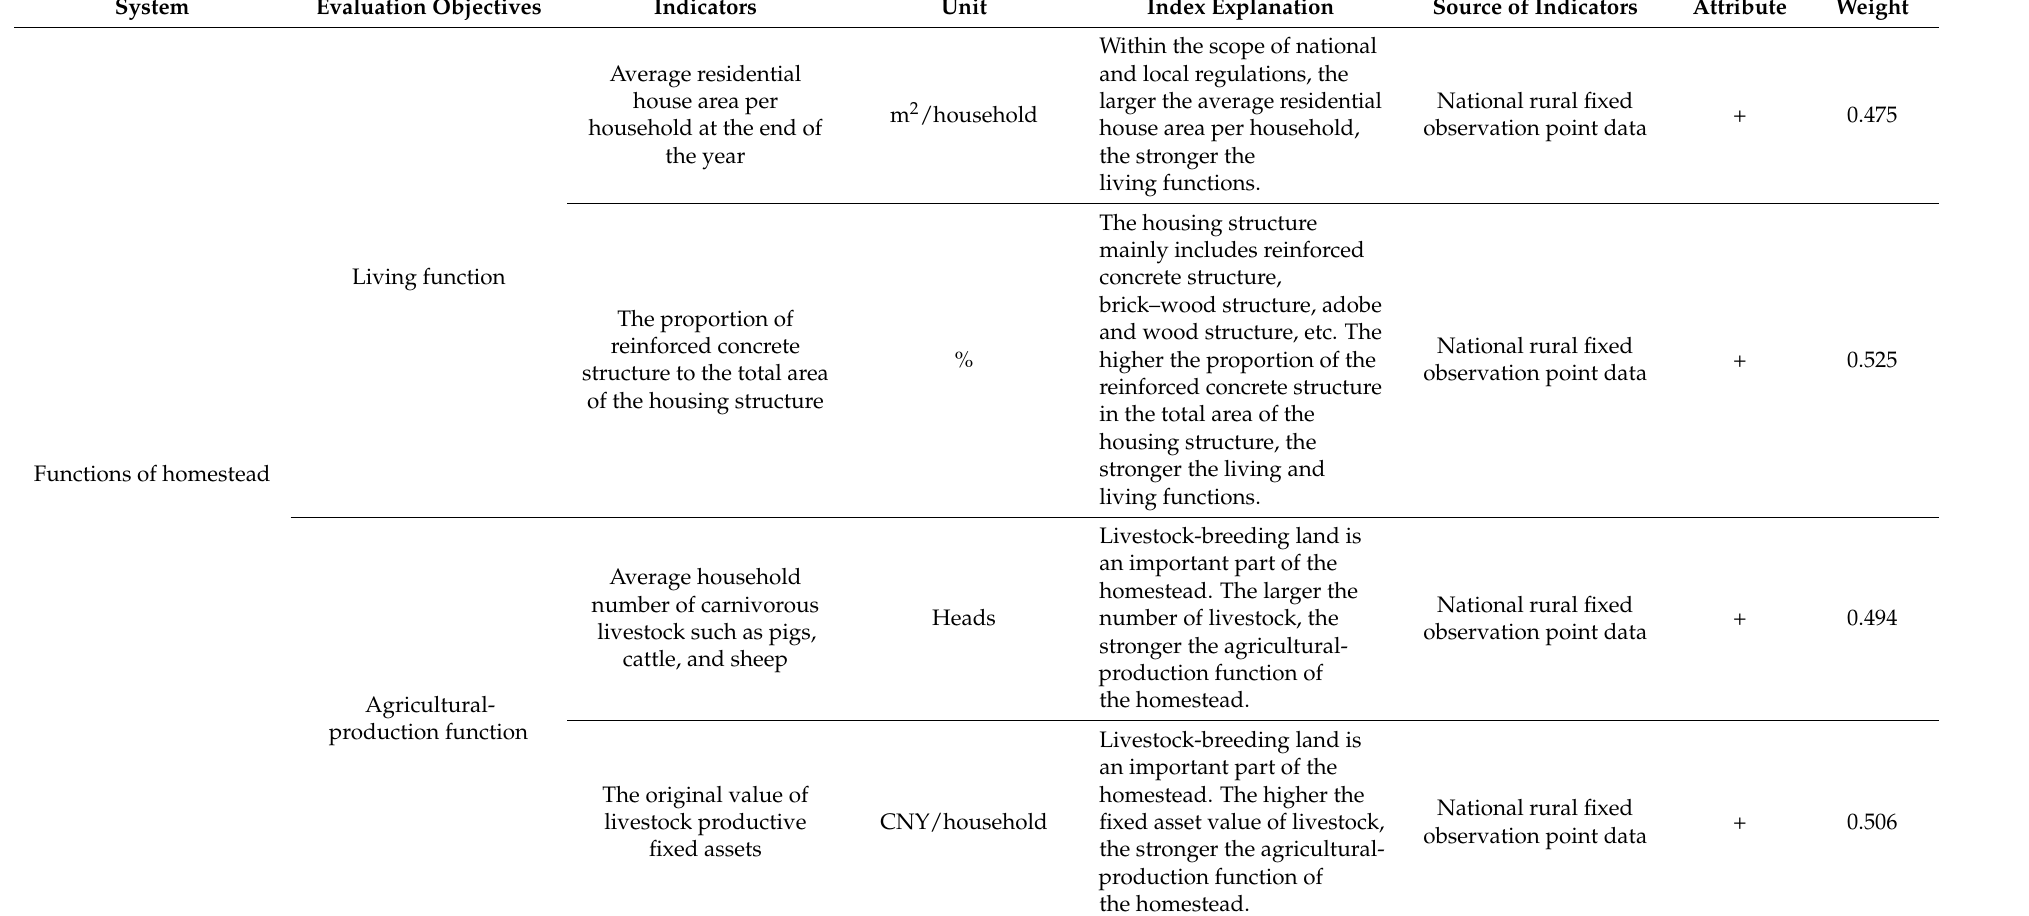
Table 1. Coupling evaluation indicator system of rural-homestead function evolution and economic development